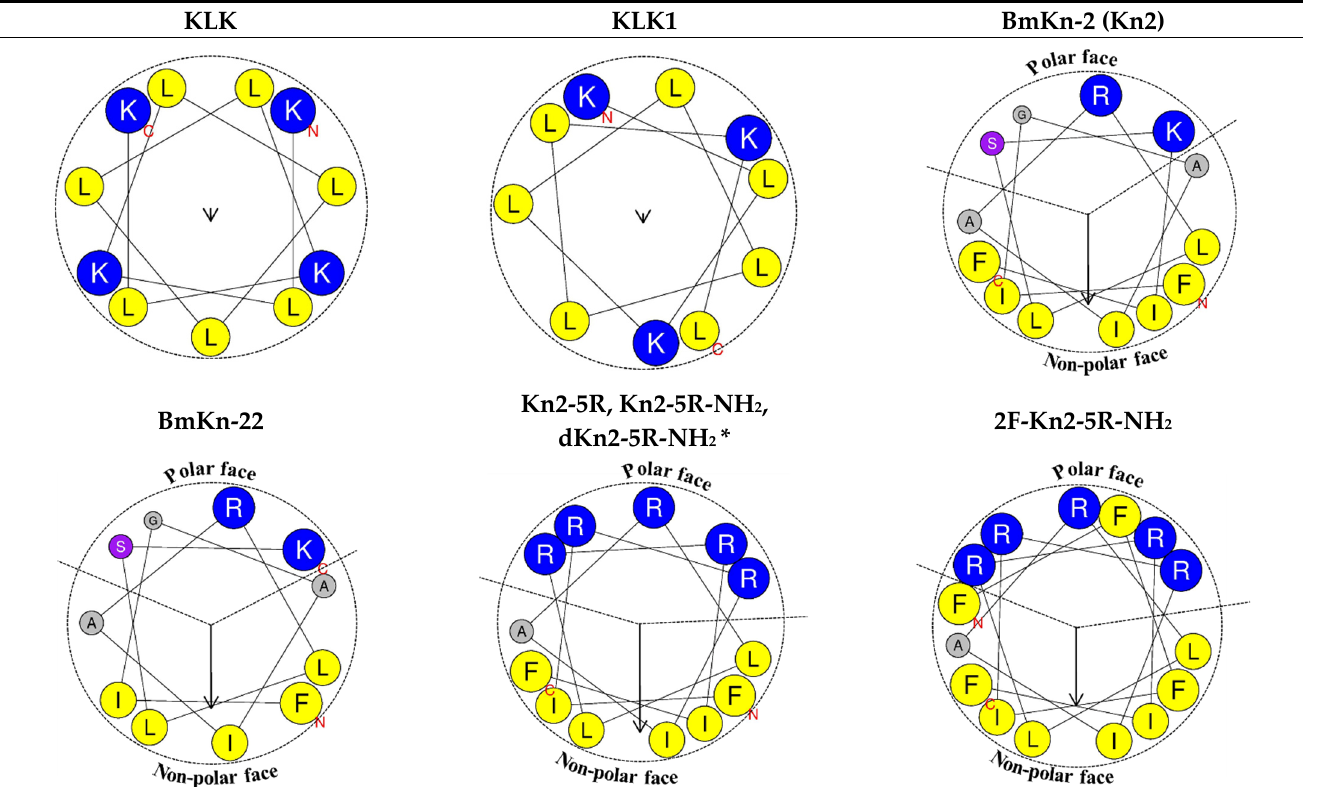
Figure 1. Helical wheel projections of α -helix peptides. The size of the circle is proportional to amino acid volume. Yellow indicates hydrophobic residues, blue indicates positively charged residue, purple indicates polar uncharged residue, and grey indicates the 2 smallest amino acids; glycine (G; polar uncharged residue) and alanine (A; hydrophobic residue). N and C letters represent N-terminus and C-terminus, respectively. The direction and length of the µH vector are represented by the arrow. * Opposite direction, a mirror image, to the figure presented ( L -enantiomer).